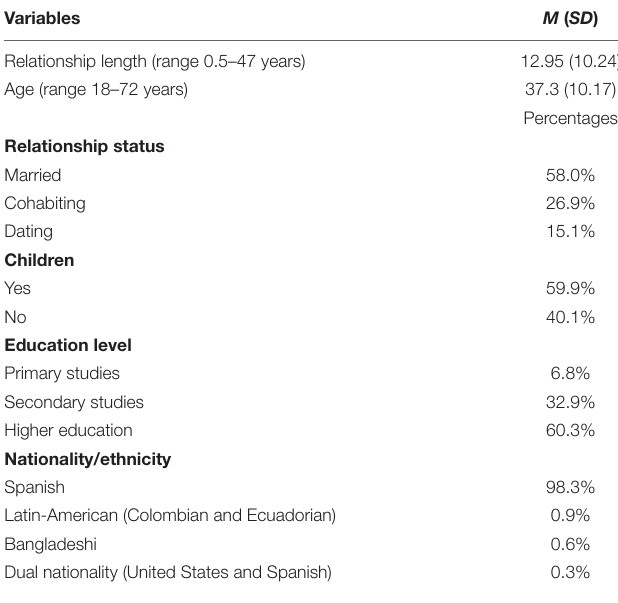
TABLE 1 | Socio-demographic characteristics of the sample ( N = 350